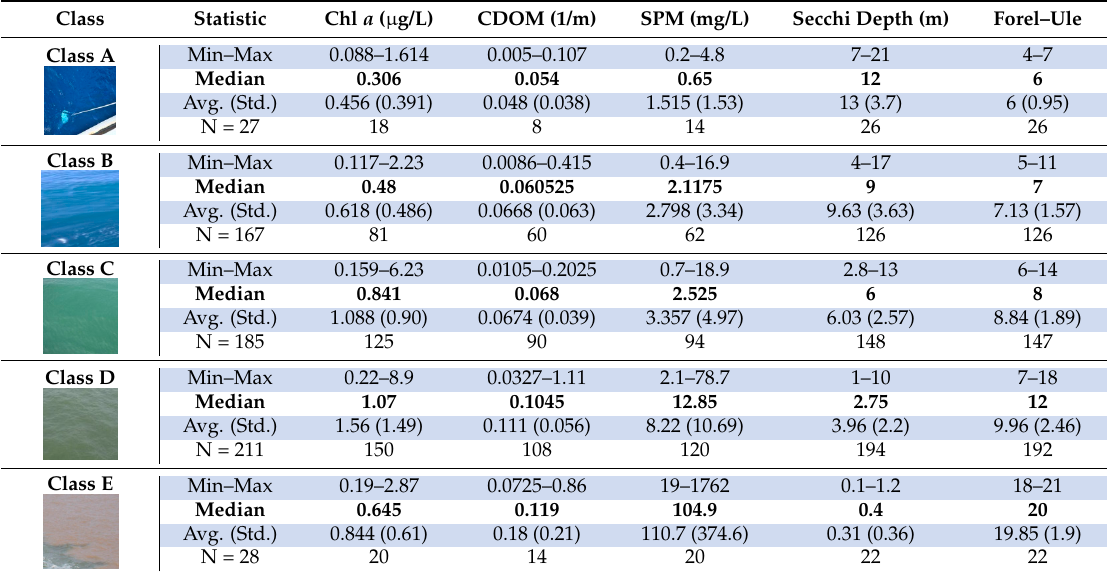
Table 1. Statistics for the in-situ data sets for Classes A–E. Min, Max, Avg., Std., and N represent the minimum, maximum, average, standard deviation, and total numbers of stations, respectively.